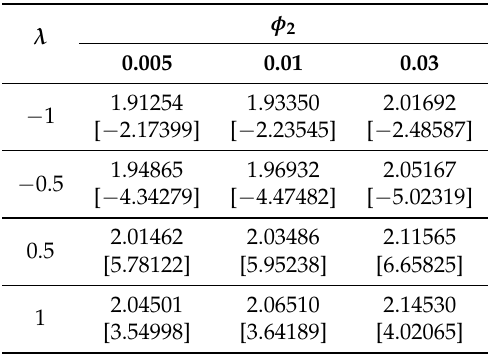
= φ = 0 ) when Z = d = 2 1